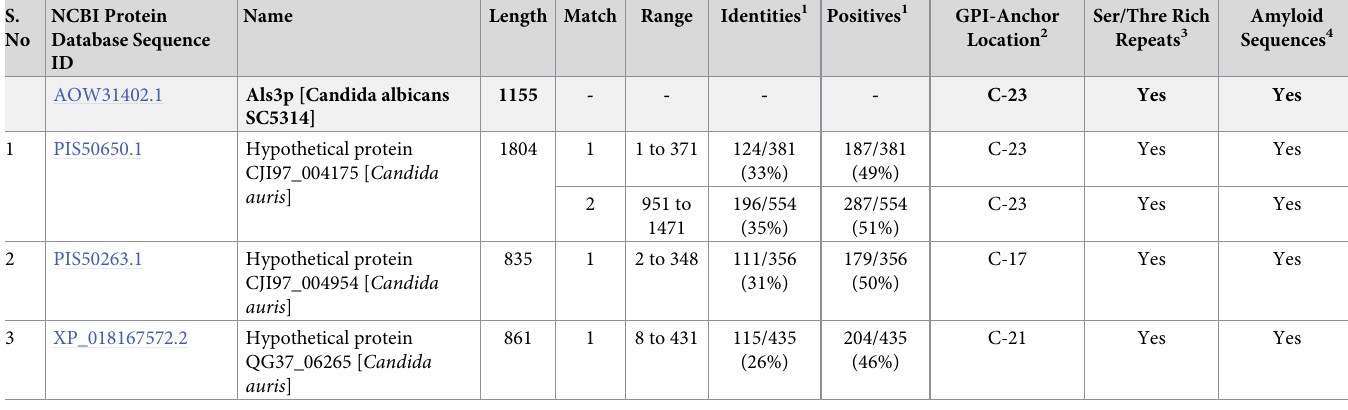
Table 1. List of the Candida albicans [SC5314] Als3p orthologs in Candida auris with percent homology and structural features. S. NCBI Protein No Database Sequence